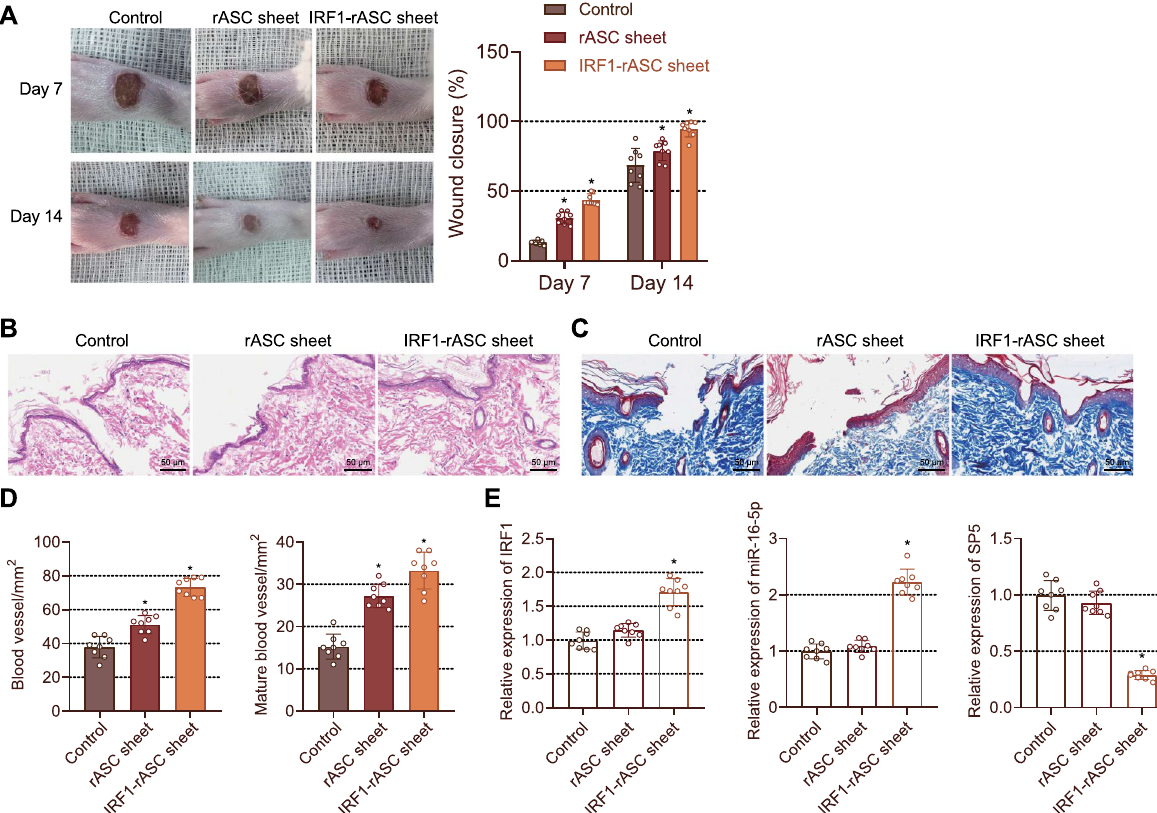
Fig. 8 IRF1-exosome loaded into the rASC sheet promotes wound healing in DM rats. DM rats were implanted with rASC sheet or IRF1-rASC sheet at the wound. A Wound healing rate of rats on day 7 and day 14. * p < 0.05 vs. control rats at the same timepoints. B Morphological and structural changes of rat wound tissues observed on day 14 by HE staining. C Collagen deposition in the rat wound tissues analyzed on day 14 by Masson staining. D Quantitative analysis of newly formed (left) and mature (right) blood vessels in rat wound tissues on day 14. * p < 0.05 vs. control rats. E Expression of IRF1, miR-16-5p and SP5 in rat wound tissues detected on day 14 by RT-qPCR. * p < 0.05 vs. control rats. n groups were compared by one-way ANOVA, followed by Tukey’s post hoc test for multiple comparisons. Repeated measures ANOVA with Tukey’s post hoc test was applied for the comparison of data at different time